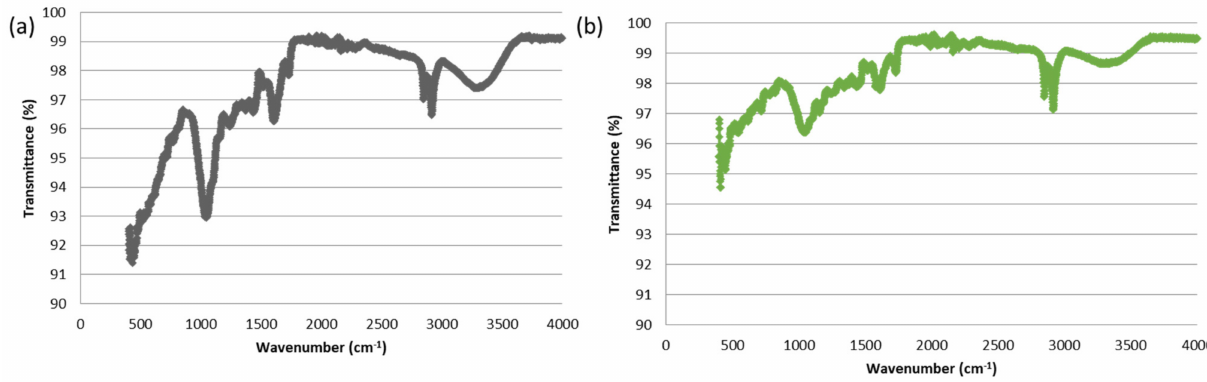
Figure 10. ( a ) FTIR spectrum of F. benghalensis leaves powder. ( b ) FTIR spectrum of F. benghalensis leaves powder after adsorption of brilliant green